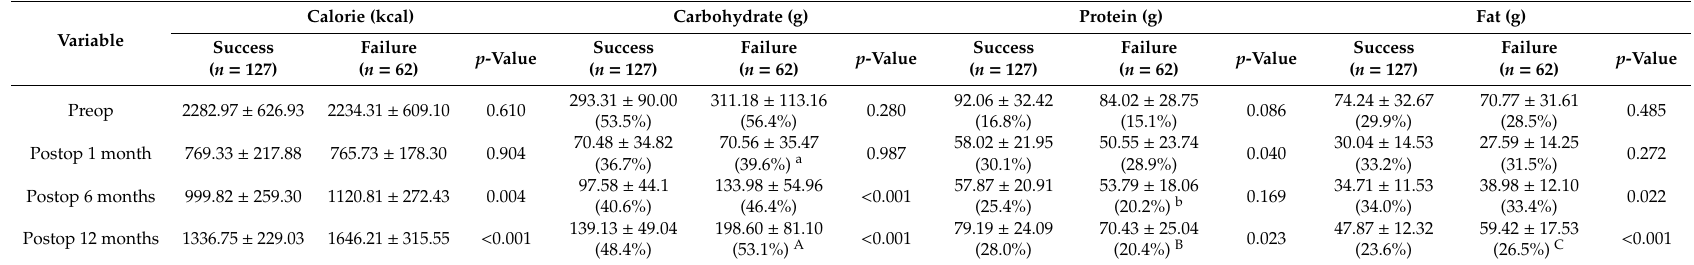
Table 3. Comparison of nutrition intakes between two